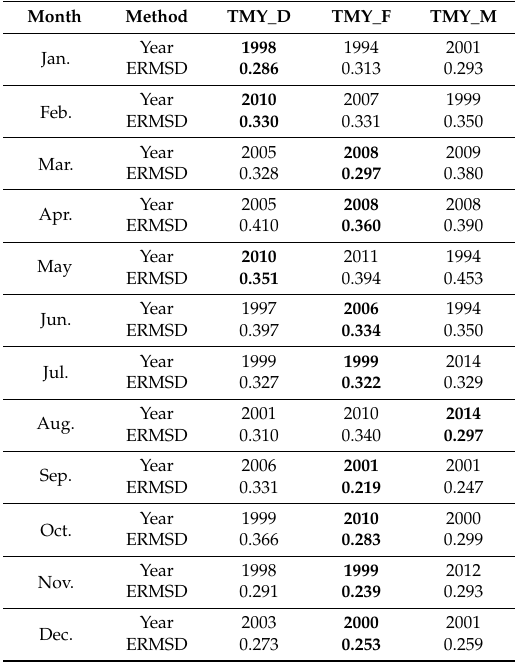
Table 4. ERMSD of the three candidate years for each month in Lhasa (the bold number shows the lowest ERMSD value in the month).